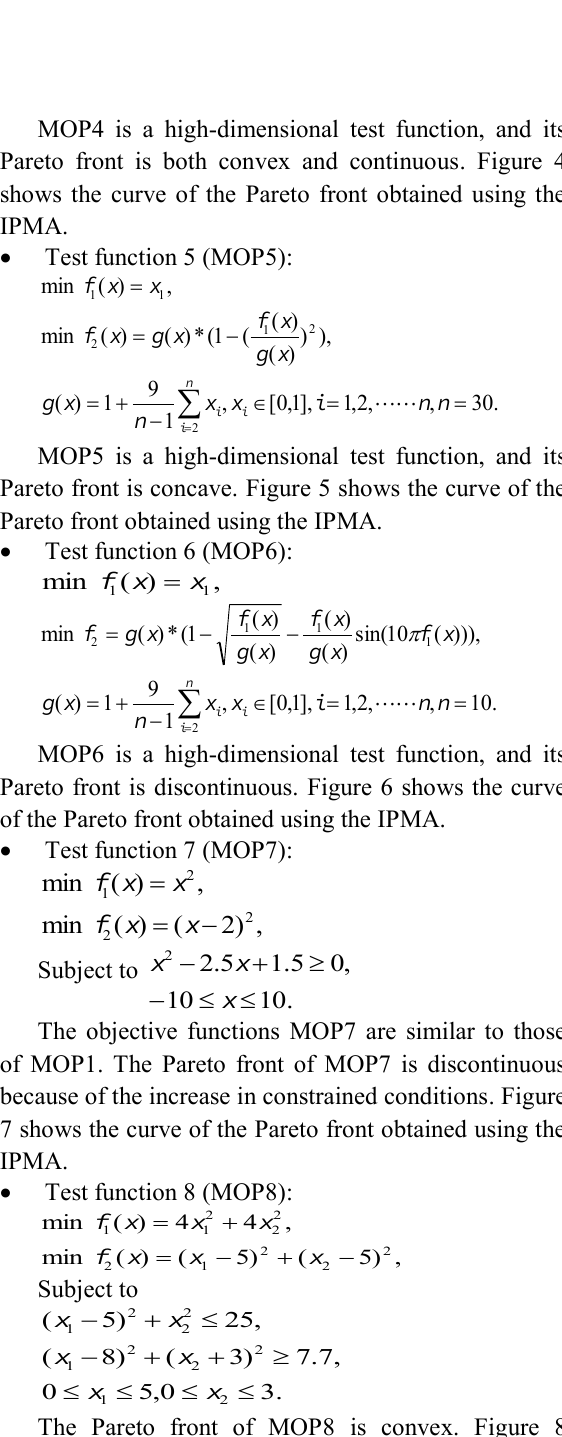
Fig.3 Pareto front of MOP3